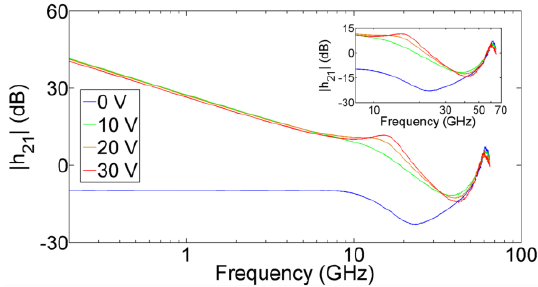
Figure 10. Measured h 21 from 0.2 to 65 GHz for a GaN HEMT at T a = 35 °C and V DS = 30 V for two values of V GS : −3 .5 V and −3 .1 V.